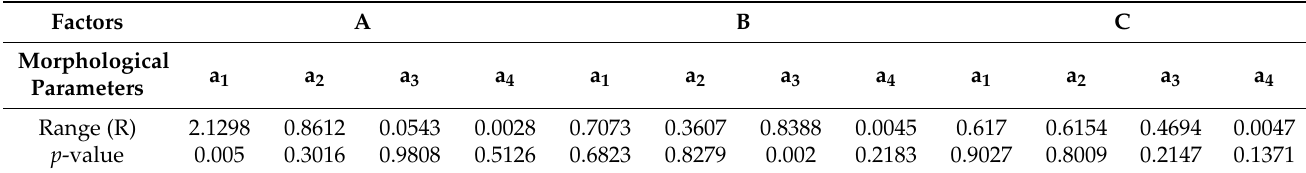
Table 7. Results of range and variance analysis of shape